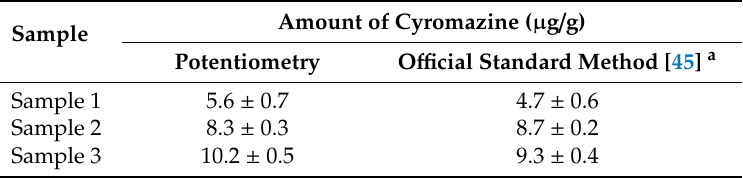
Table 4. Determination of cyromazine in some soil samples using MIP /